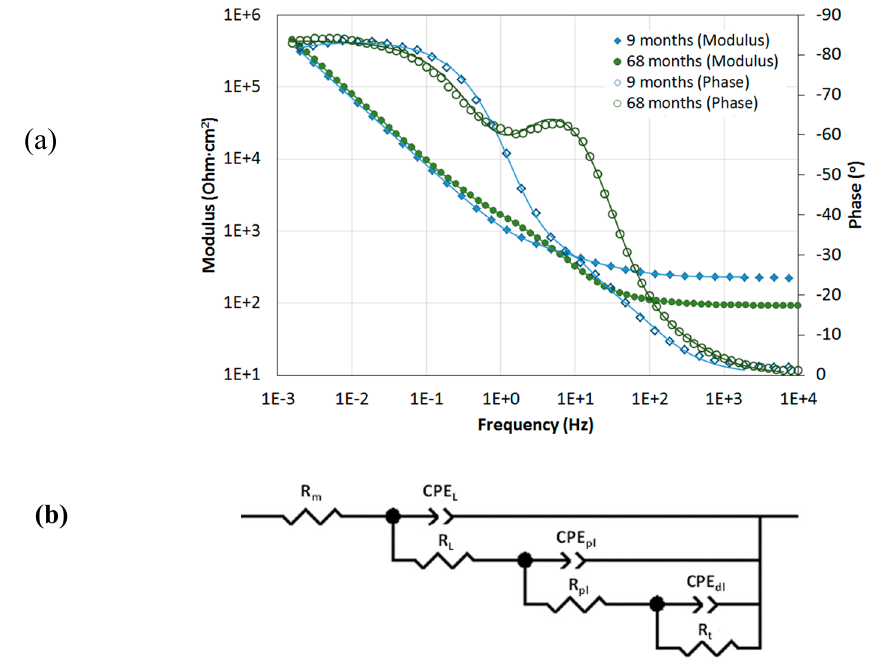
Figure 6. ( a ) Examples of electrochemical impedance spectroscopy (EIS) spectra, corresponding to S32001 steel tested under HH condition at two different times. Dots correspond to experimental data, and lines correspond to fitting. ( b ) Equivalent circuit used to simulate all the EIS spectra.